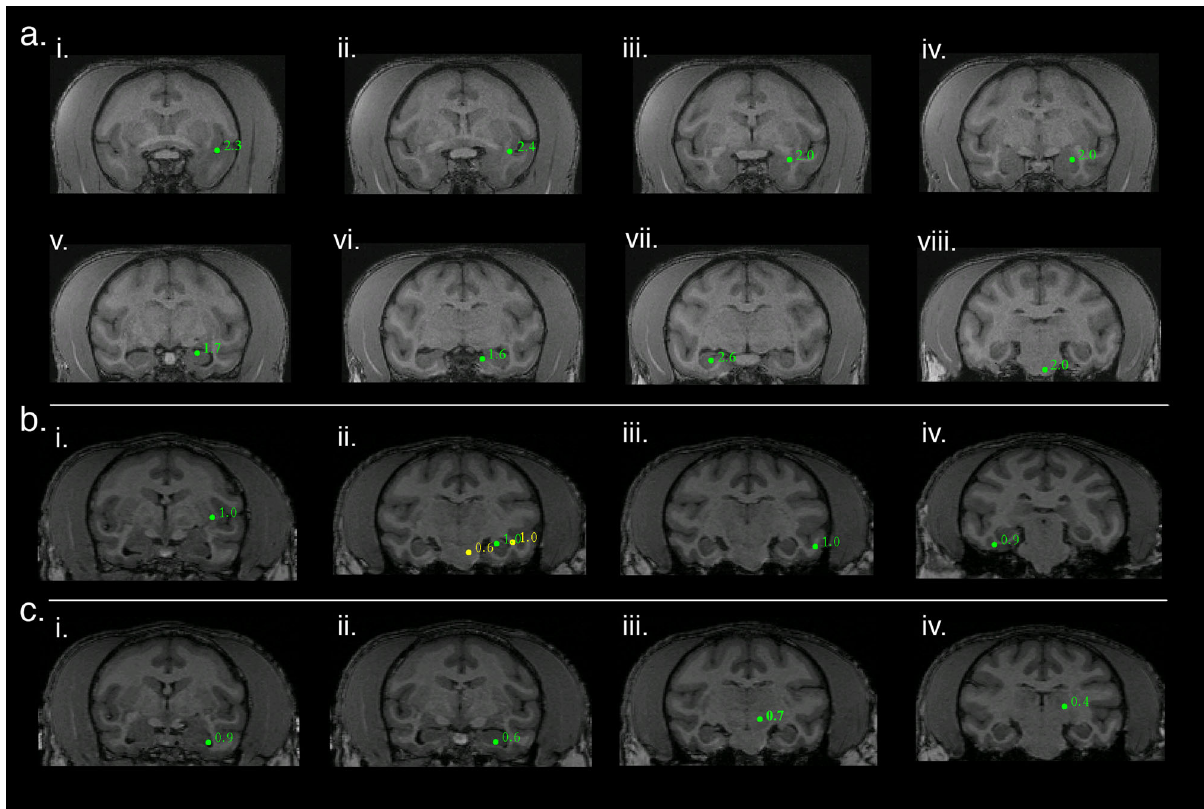
Fig. 5 Hippocampal optogenetic stimulation results in propagation through downstream networks across animals. a Functional hippocampal and temporal networks in NHP M3 engaged by a 20 Hz optical sine input to left hippocampus ( v ) with SAM peaks as follows: ( i ) left insular proisocortex/ temporopolar proisocortex, ( ii ) left para-insular cortex, ( iii ) left dorsolateral amygdala (lateral n.), ( iv ) left basolateral/lateral amygdala, ( v ) left hippocampus, site of stimulation, ( vi ) left parasubiculum/presubiculum of hippocampus, ( vii ) contralateral (right) hippocampus, and ( viii ) left pontine reticular activating formation. b A second example of hippocampal network activity in a different NHP (M1) in response to 8 Hz sine wave input with SAM peaks as follows: ( i ) left putamen, ( ii ) PGa/IPa association areas of left temporal cortex (lateral yellow peak), left hippocampus (green peak, site of stimulation), and possible left red n. (yellow, medial peak), ( iii ) area TEA/TEM of left temporal cortex, and ( iv ) area TL/TFM of right temporal cortex. c A third example of hippocampal network activity in response to 40 Hz sine wave input (same subject as in b ) with SAM peaks as follows: ( i ) left anterior hippocampus, ( ii ) left hippocampus, site of stimulation, ( iii ) left deep mesencephalic n., and ( iv ) left pulvinar n. of